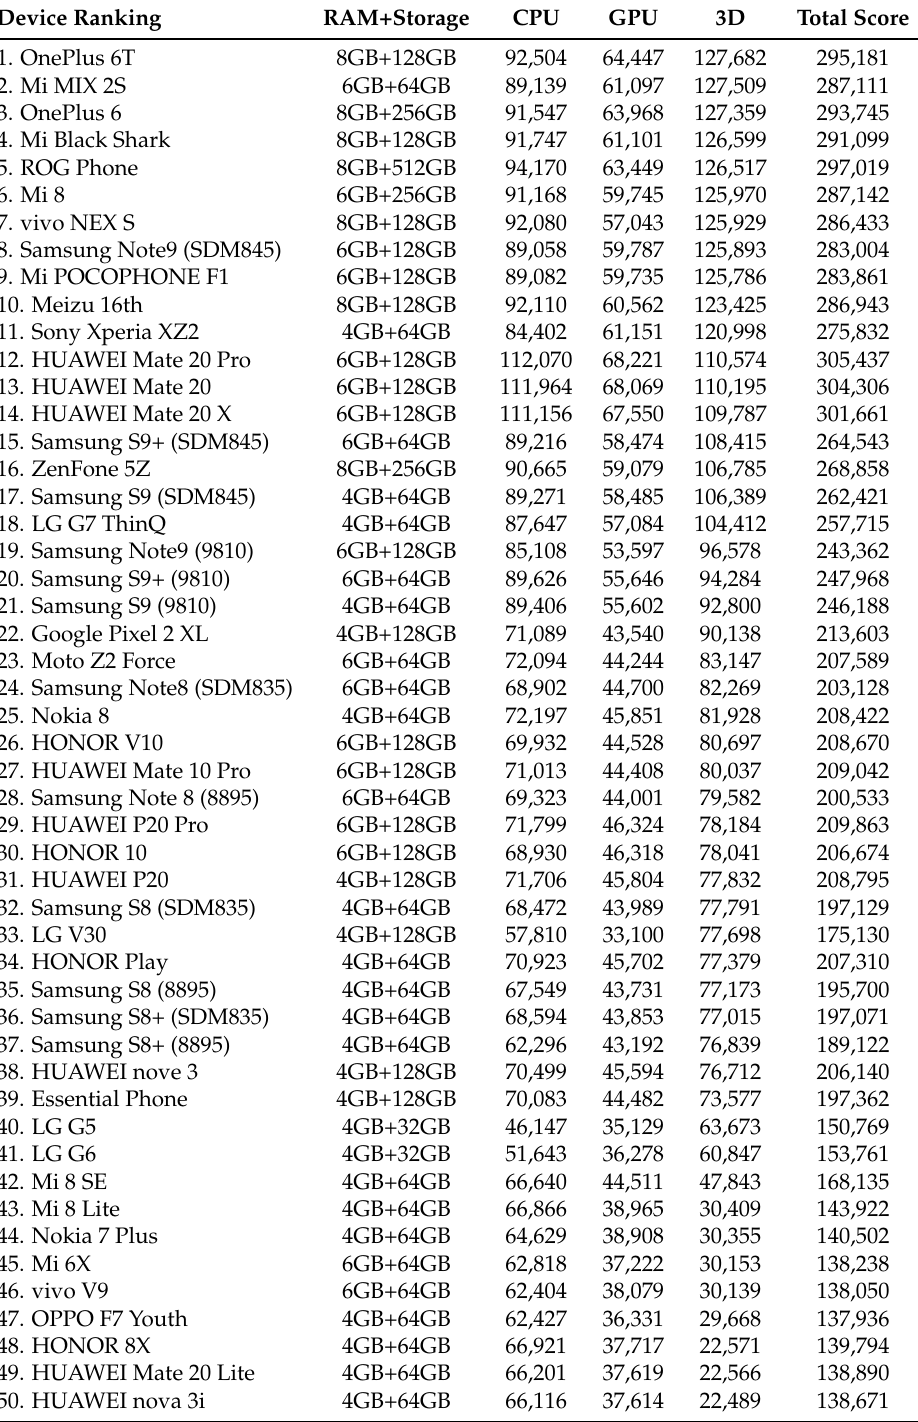
Table 3. Top 50 AnTuTu benchmark scores on popular Android smartphones (as of November 2018), retrieved from